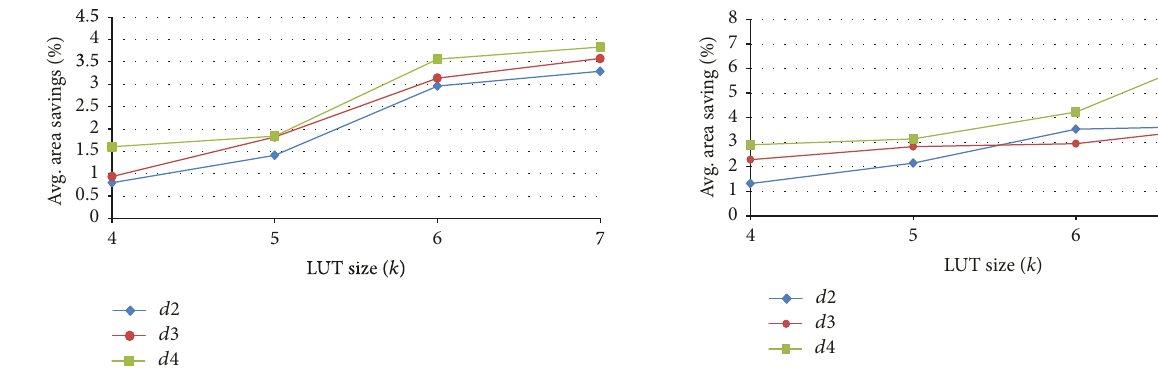
Figure 11: Average area savings for 𝑁 = 10 and 𝑘 = 4–7 over the 20 MCNC benchmark circuits.